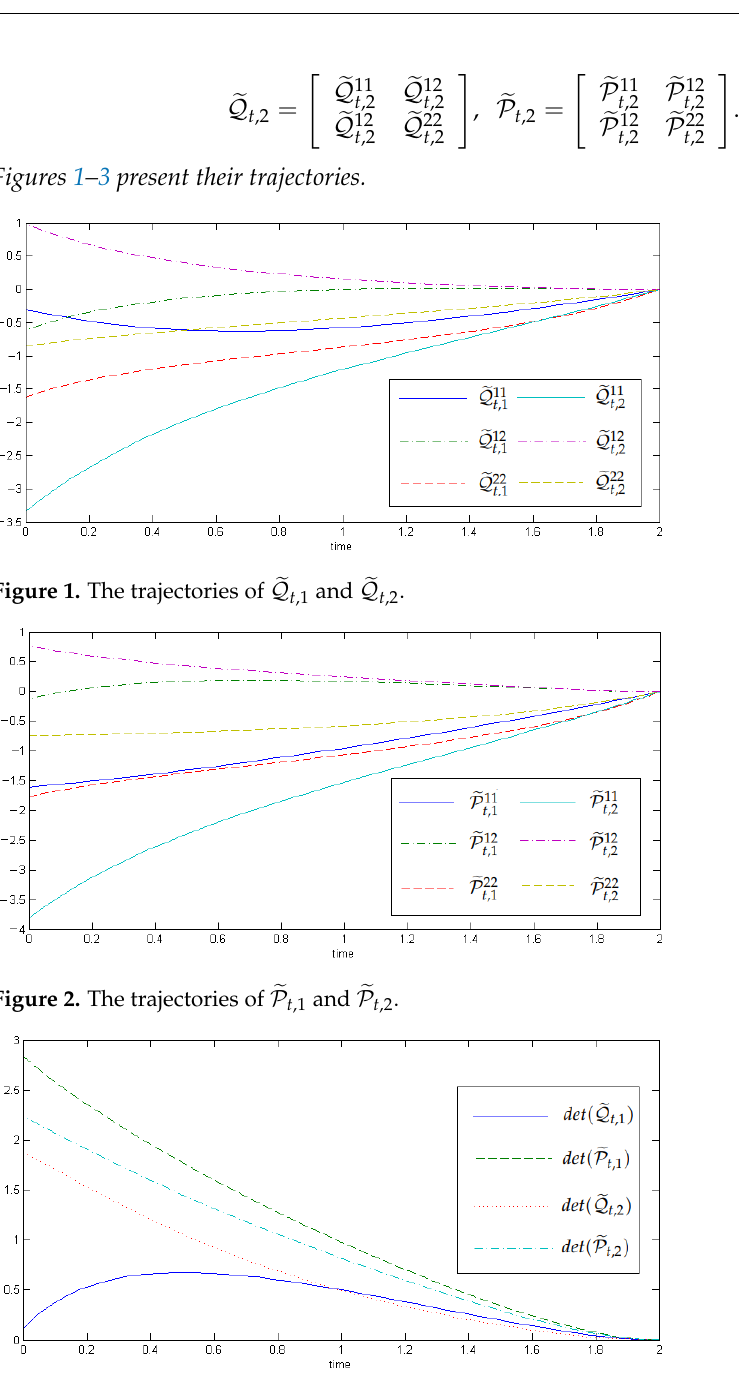
Figure 3. The trajectories of det ( (cid:101) Q t ,1 ) , det ( (cid:101) Q t ,2 ) , det ( (cid:101) P t ,1 ) , and det ( (cid:101) P t ,2 )